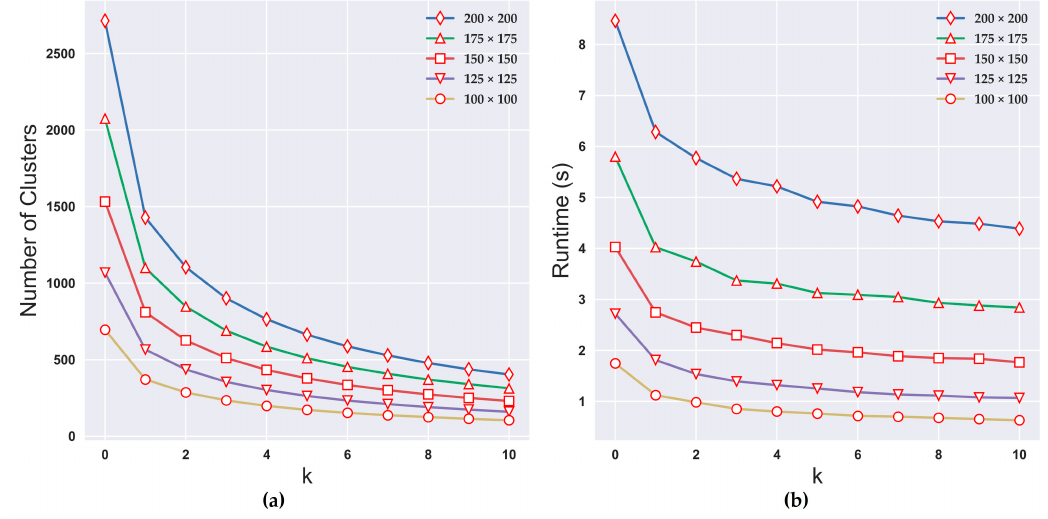
Figure 13. ( a ) The number of clusters as a function of k. ( b ) The runtime as a function of k.